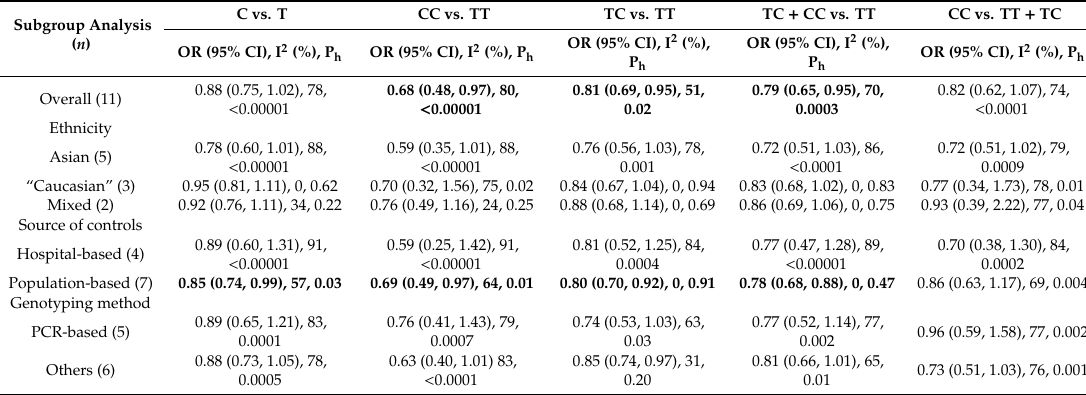
Table 2. Subgroup analysis of the risk of non ‐ syndromic cleft lip/palate related to rs13041247 MAFB polymorphism.